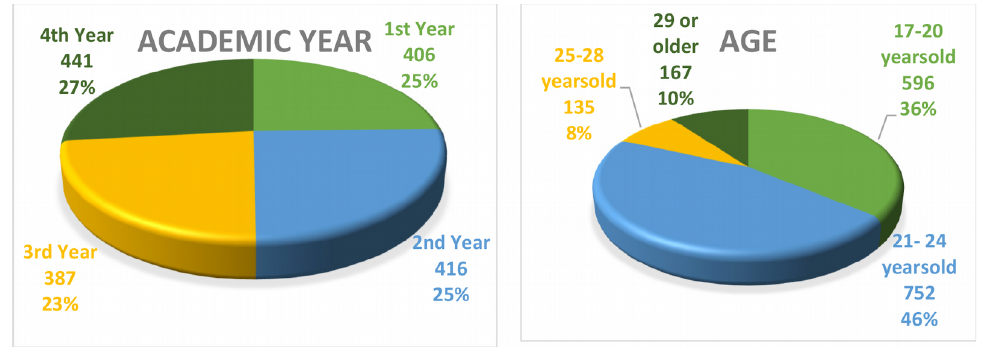
Figure 1. Participants’ information according to age and academic